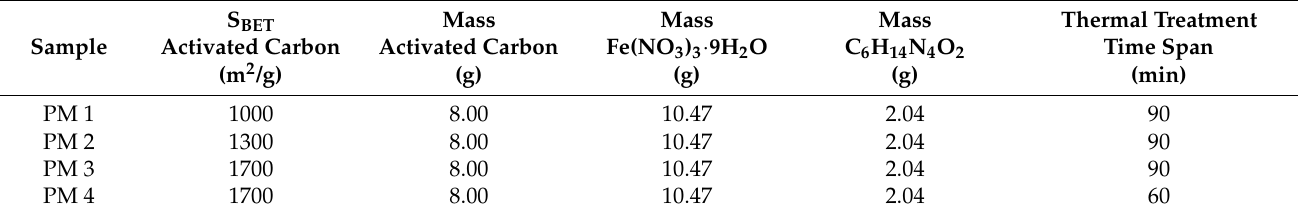
Table 1. Conditions for the synthesis of magnetic